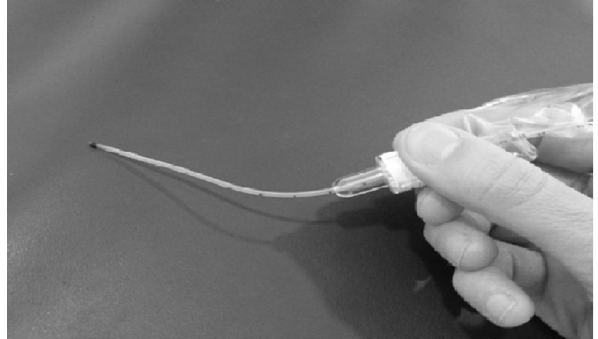
Figure 1 - A 5-gauge French, gamma-sterilized, multi-access catheter specifically designed to deliver surfactants in neonates/ pediatric